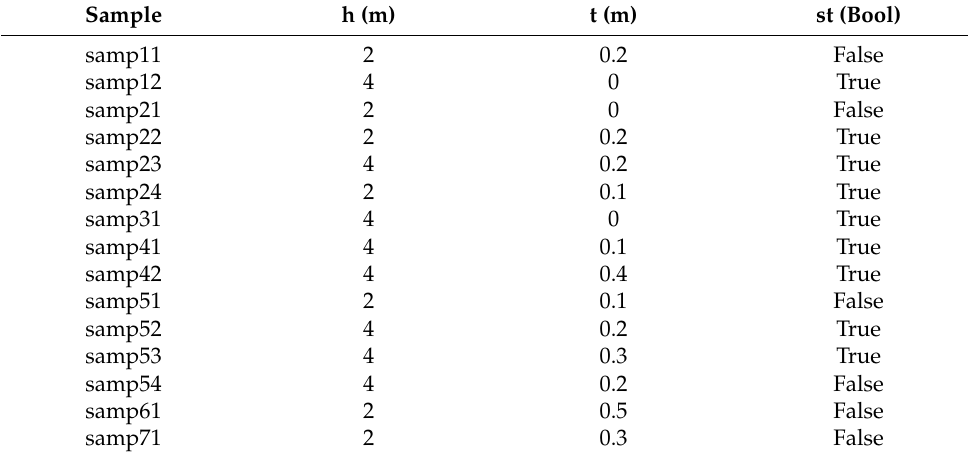
Table 3. The initial grid resolution and residual threshold used in the ASI procedure.